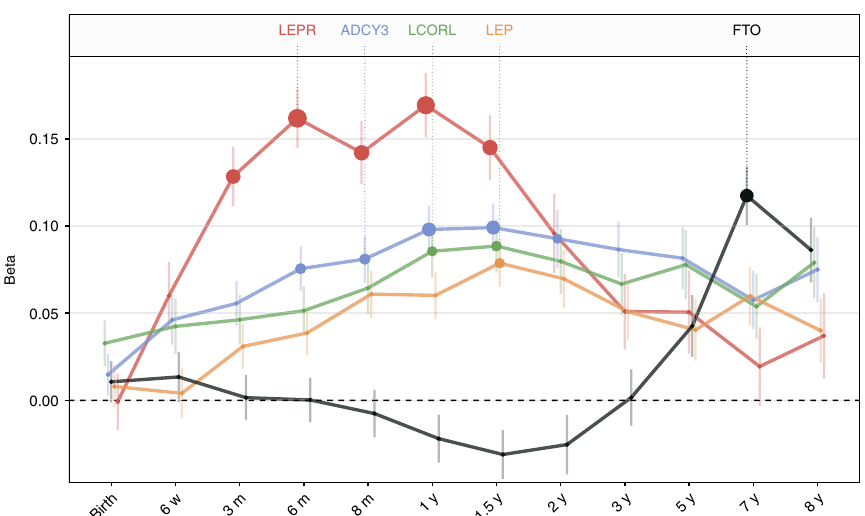
Fig. 3 Effect sizes for all time points. Regression betas are plotted in BMI-sd units at each time point for lead SNPs in LEPR (rs2767486), ADCY3 (rs13035244), LCORL (rs6842303), LEP (rs10487505), and FTO (rs9922708) in colors as in Fig. 2. Results are presented for the meta-analysis of discovery and replication sample. The size of the points is proportional to − log 10 ( p -value of the association). Error bars represent one standard error of mean (SEM) on each side of the